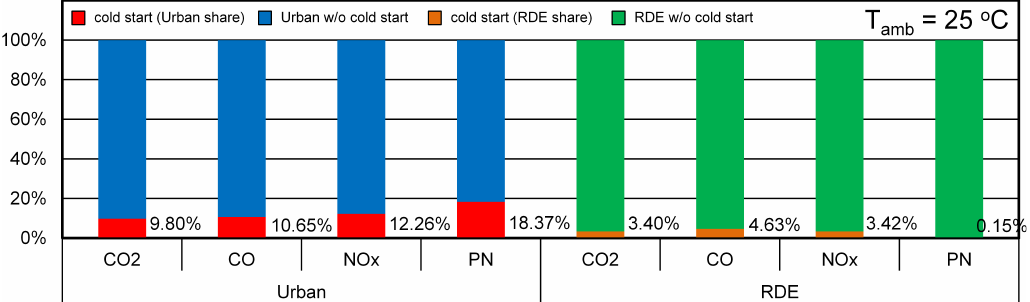
Figure 11: The share of exhaust emissions during the cold start in relation to the urban part of the RDE test, and the entire RDE test for an ambient temperature of 25 ∘